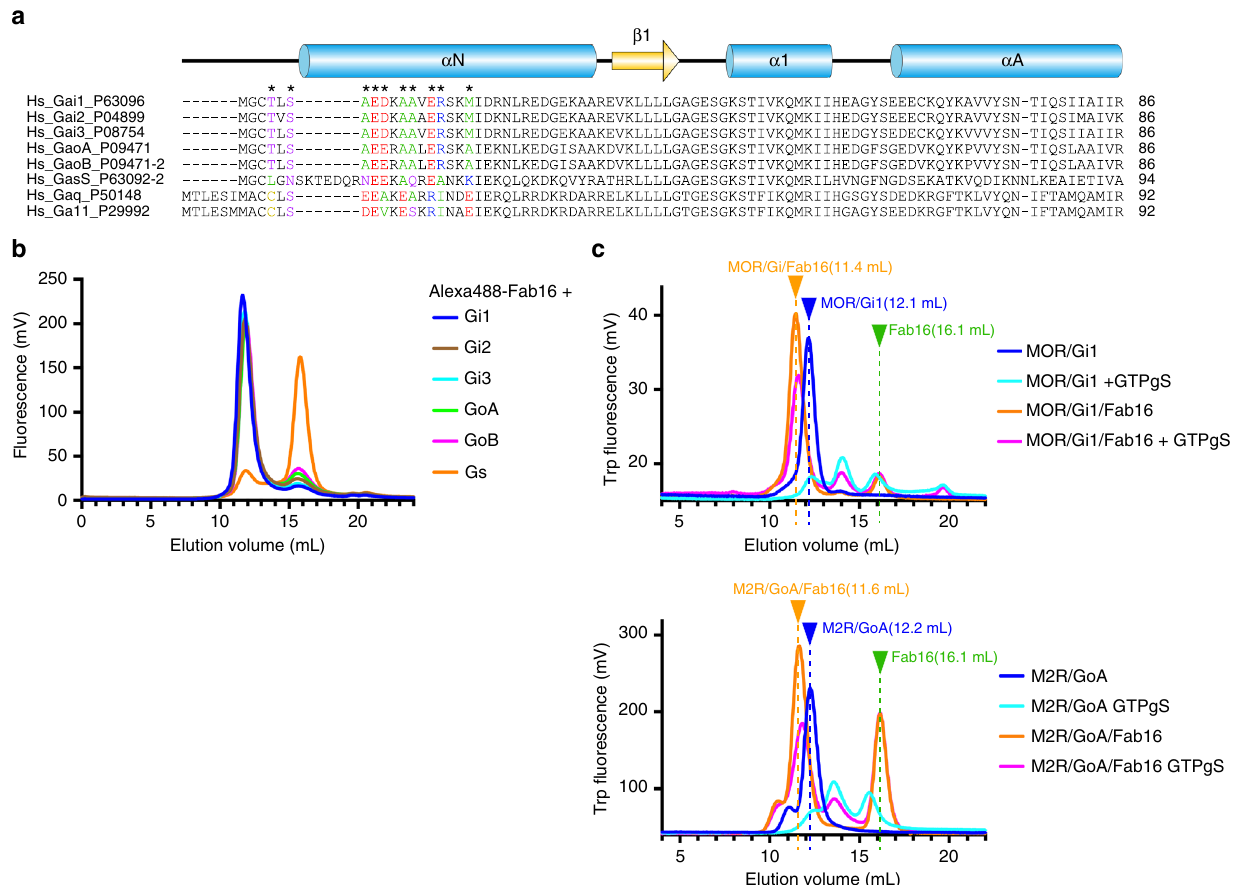
Fig. 3 Sequence alignment of G-protein family members and binding pro fi le of Fab16. a Multiple sequence alignment of amino-termini of representative G α subunits from human. UniProt numbers are provided after each G-protein subtype name. Secondary structures are shown as cylinder (helix) and arrow (strand). The asterisks indicate the residues in contact with scFv16 in G α i1 and those corresponding residues are coloured according to their property: Positive in blue, negative in red, hydrophobic in green, polar in purple, cysteine in yellow. b Fluorescent SEC analysis of binding of the fl uorescently labelled Fab16 with G-protein family members. c Analytical tryptophane fl uorescent SEC of μ OR/G i1 and M 2 R/G oA with GTP γ S in the presence or absence of Fab16. Each complex alone runs around 12.2 mL. Upon binding to Fab16, they run at 11.4 mL or 11.6 mL indicating the binding of Fab16 to these GPCR/G-protein complexes. Excess free Fab16 runs at 16.1 mL. Dissociated components upon incubating with GTP γ S show smaller peaks at 13.5 – 16